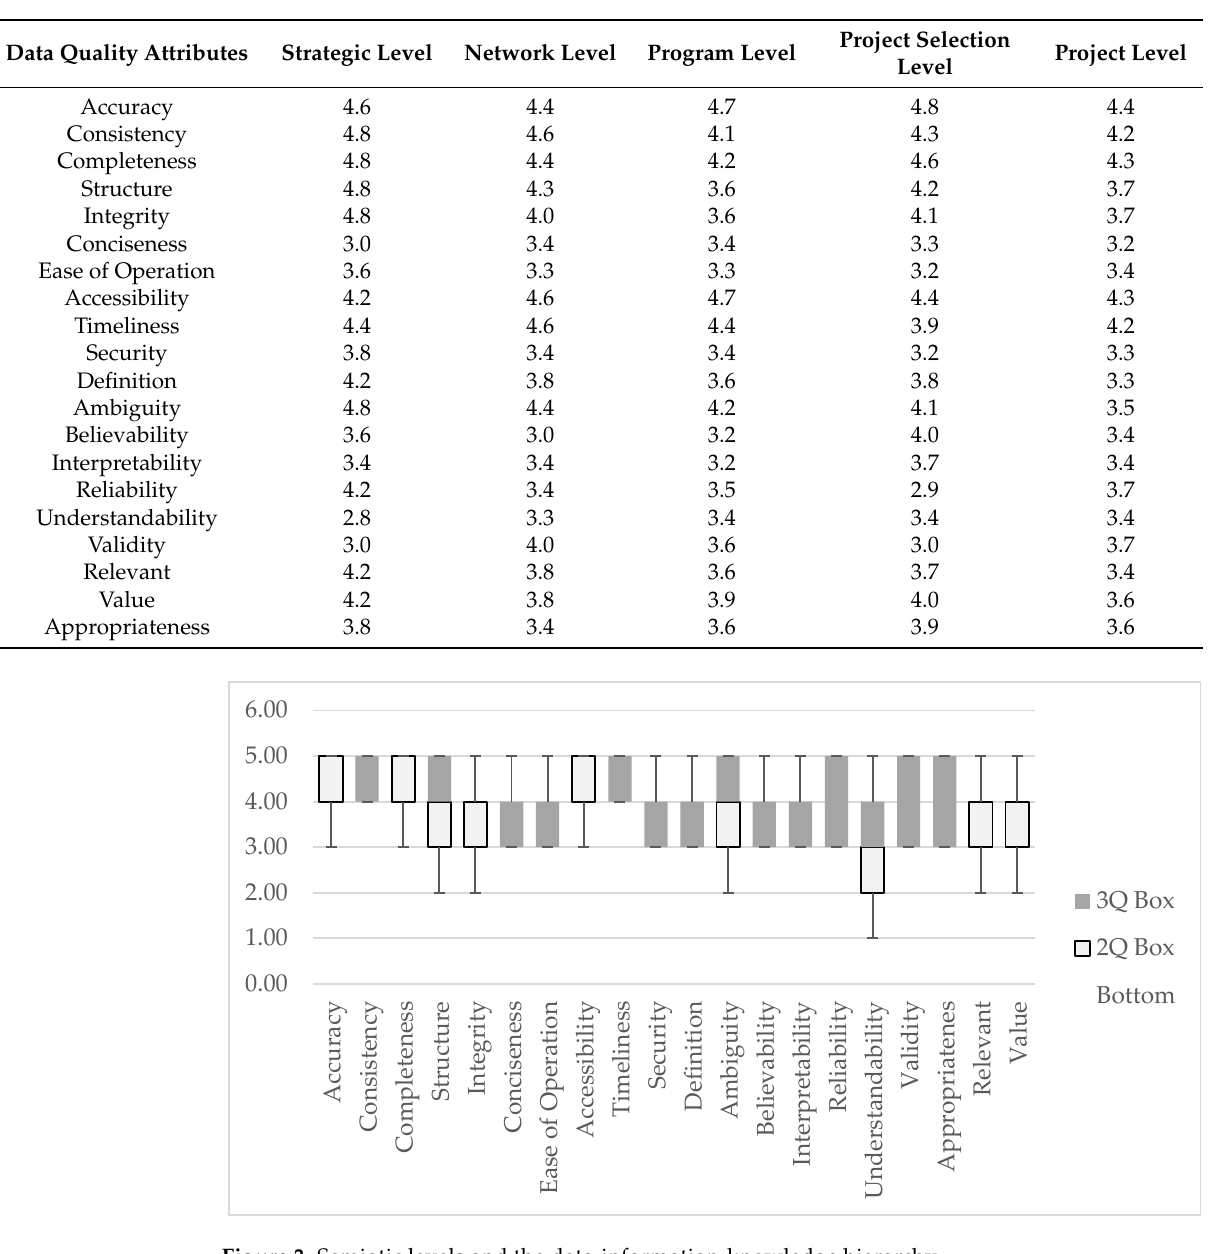
Table 4. Decision-maker’s level of importance of dimensions.